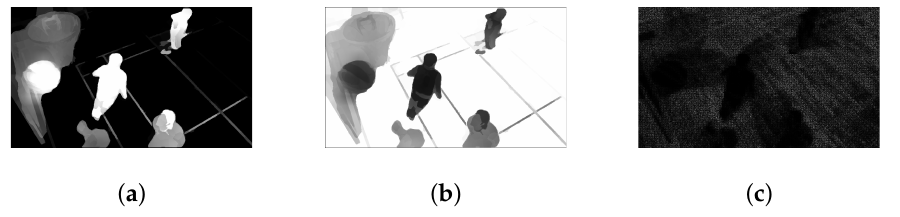
Figure 12. ( a ) The semantic-based spatial attention A F ( x ) map; ( b ) The spatial attention weight w s ( x ) map; ( c ) The proposed JND threshold map.